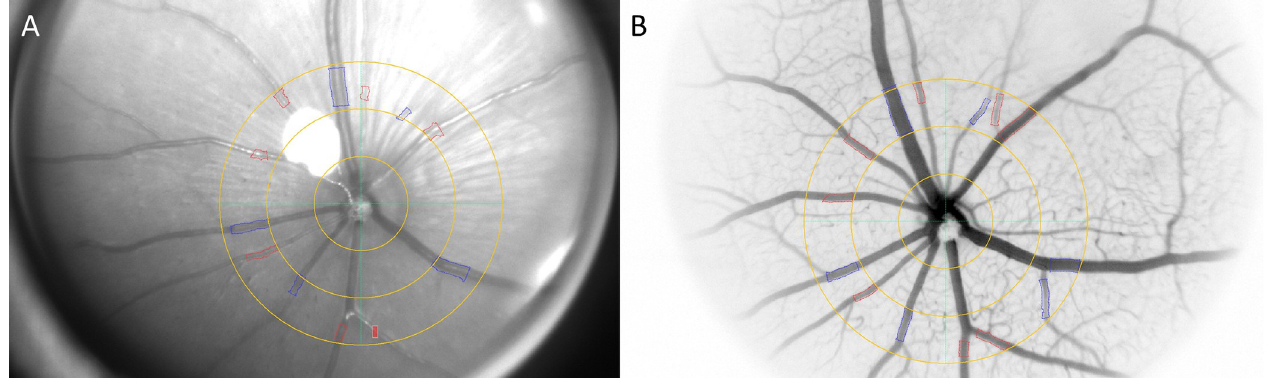
Fig 2. Fundus images with marked vessel segments of one mouse without and with fluorescein. Retinal vessels of one mouse without (A) and with fluorescein (B) with marked arteriolar (red) and venular (blue) vessel segments. Three images of eight mice with and three images of eight mice without fluorescein were averaged by investigator one and two separately to investigate interobserver variability. Twenty images without and 20 images with fluorescein were analysed by one investigator twice to investigate intraobserver variability.